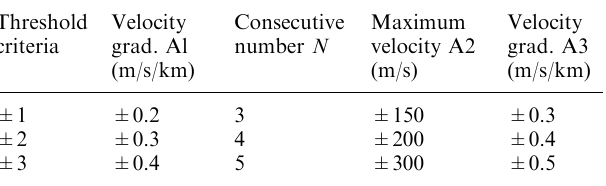
Table 2. The threshold criteria of the definition of ion upflow and downflow Threshold Velocity criteria grad.